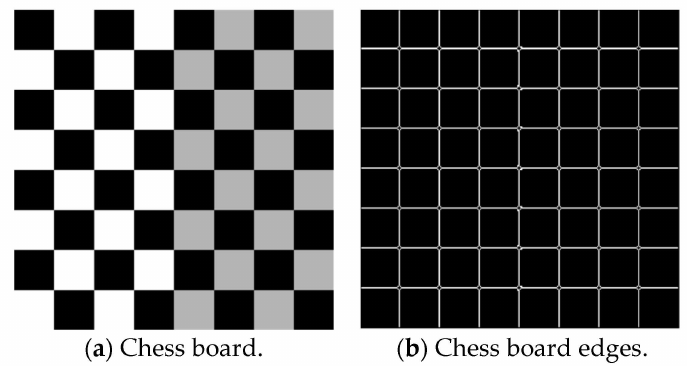
Figure 12. Test image and their edges detected.